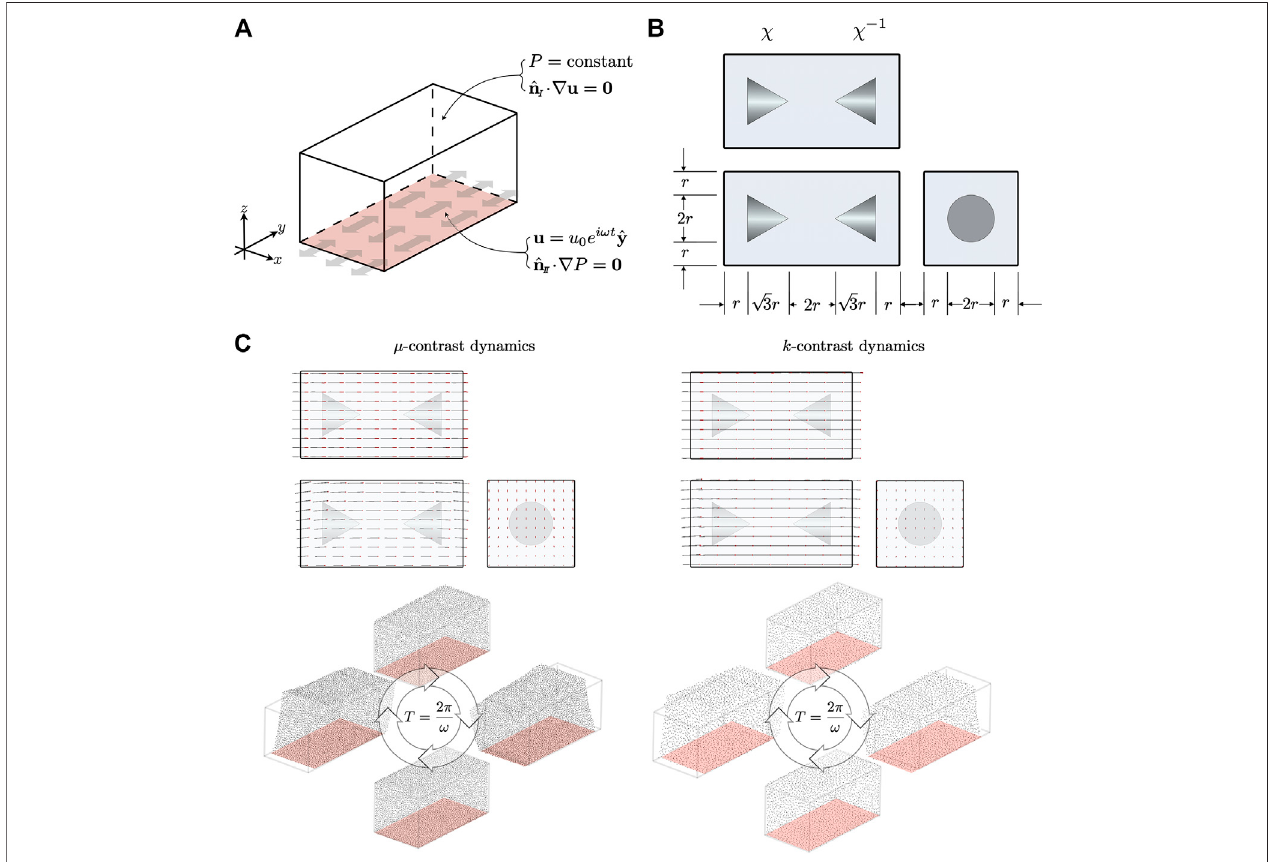
FIGURE4|(A) Boundaryconditionsonthetop/sides( I )andbottom( II )surfacesforthe10Hzsimulation. (cid:1) n areoutwardpointingnormals.PressurehasDirichletBCs on I andNeumannBCson II .Displacementhastheopposite.Thebottomplateoscillatesinthe y directionatfrequency ω . (B) Orthographicprojectionshowinggeometry oftheconicalinclusions.Theleftinclusionhaspositivepropertycontrast,andtherightonehasanegativepropertycontrast. (C) Thedynamicsofbothscenarios-theleft fi gure has inclusions with shear modulus contrast, while the right fi gure has inclusions with hydraulic permeability contrast. The MRE f displacement fi eld over one period is shown for both, the red dots representing in-phase displacements at the start of a cycle. Below these, the motion of the boundary nodes is displayed at four equally spaced times within the cycle of period T .